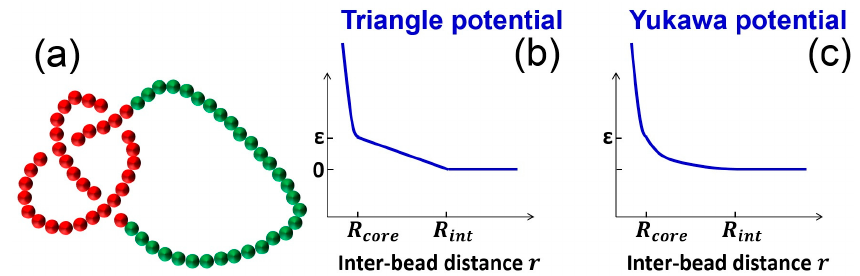
Figure 1. Simulation setup. ( a ) Snapshot of a knot in a homogenous circular chain. The monomers in the knot core are in red, while other monomers are in green; ( b ) Triangle potential for the pairwise interactions between monomers; ( c ) Yukawa potential (screened electrostatic interaction) for the pairwise interactions between monomers.